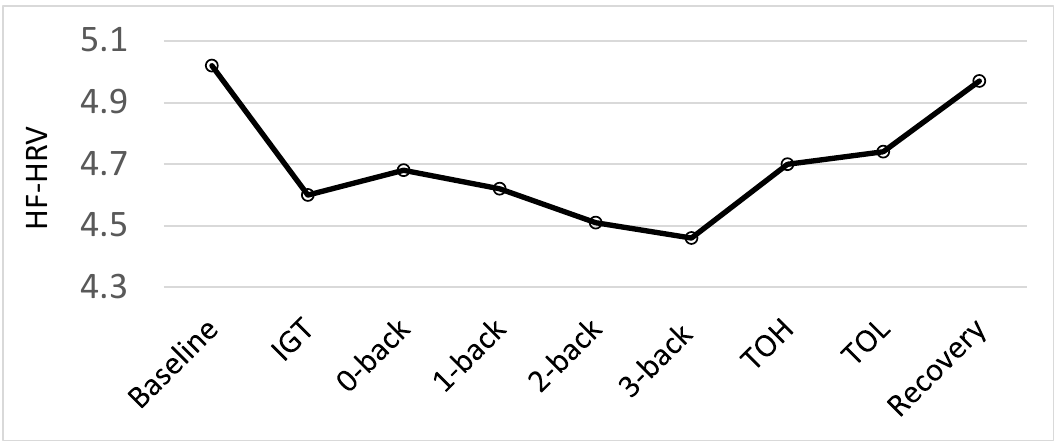
Figure 2. Psychophysiological responses (High-frequency heart rate variability; HF-HRV) during each condition: baseline, Iowa Gambling Tasks (IGT), N-back tasks (0-back, 1-back, 2-back and 3-back), Tower of Hanoi (ToH), Tower of London (ToL) and recovery, before the intervention for all participants.